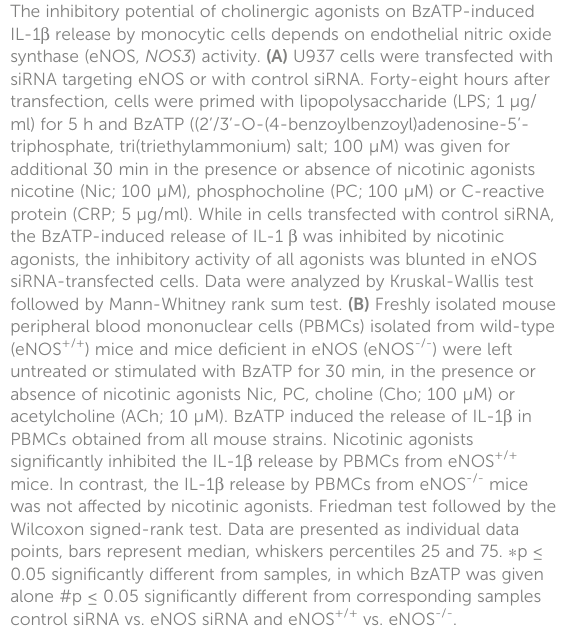
agonists on IL-1 b release. NOS catalyzes the conversion of L- arginine into NO and L-citrulline (34). Highly reactive peroxynitrite